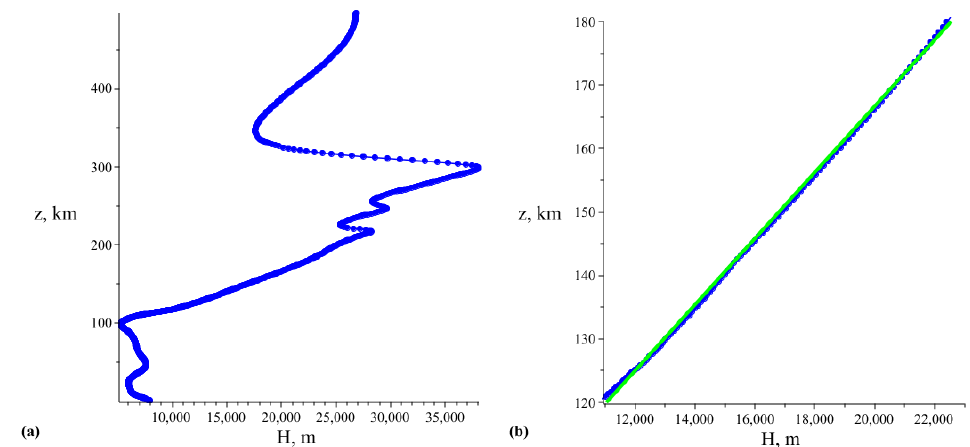
Figure 2. ( a ) The atmosphere’s scale height H ( z i ) profile obtained according to the formula (25) [24]; ( b ) The atmosphere’s scale height H ( z i ) for z i within 120 km to 180 km range (in blue) and its linear approximation represented by formula (27) (in